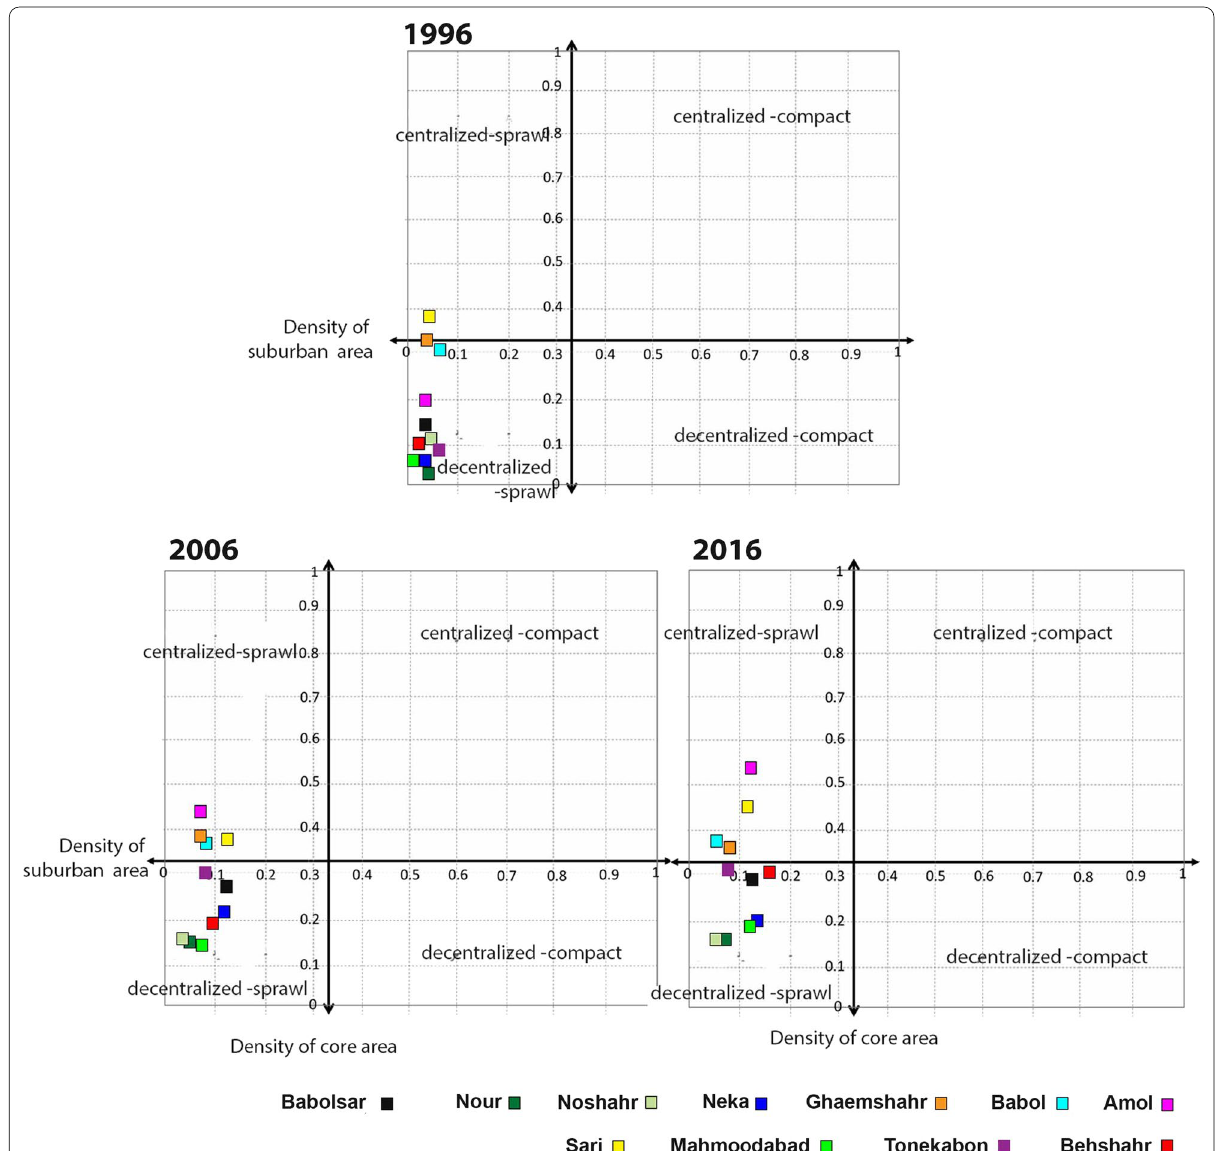
Fig. 5 Spatial patterns of land consumption based on the density of core and suburban areas in 1996, 2006,